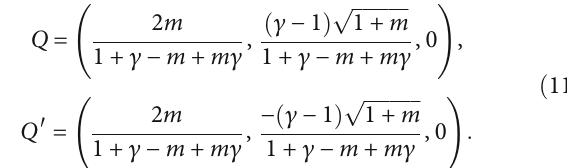
System (10) of ordinary di ff erential equations de fi nes a dynamical system symmetric with respect K axis. Equilib- rium point ð 1, 0, 0 Þ is repeated twice. Note that for γ = 1 , equilibrium points Q and Q ′ degenerate to ð 1, 0, 0 Þ . It is well known in the literature that γ = 1 corresponds to iso- thermal case, and it is no surprise that (24) too give rise to self-similar solutions of system of Euler ’ s equations with spherical and cylindrical symmetry obey condition of being isothermal. Figure 1 illustrates the vector fi eld determined by (11) in the fi rst quadrant of the I − K plane. The point Q represents transitional solution. The region represents invariant region for the vector fi eld (10). The points ð 0, 1 Þ and ð 1, 0 Þ and Q are equilibrium points which are sepa- rated by separitrices. In the following sections, we have carried out phase plane analysis of the vector fi eld